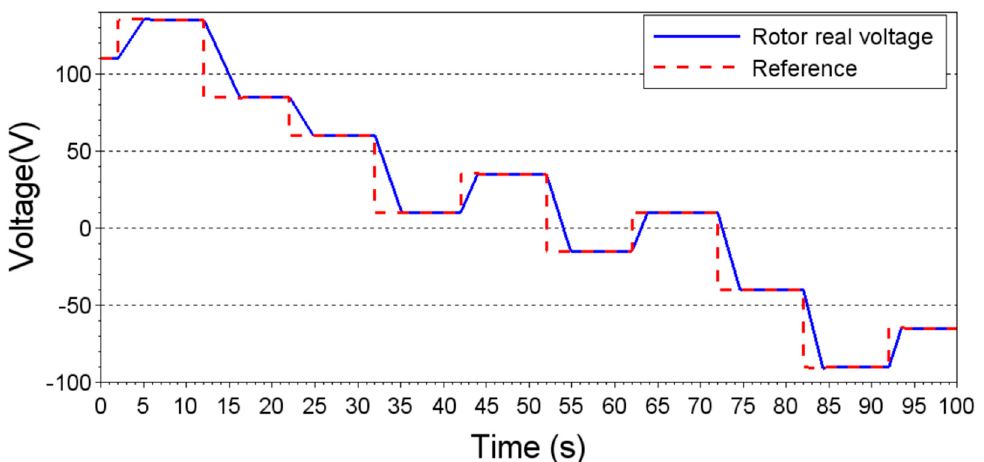
Figure 4. Wind speed profile.